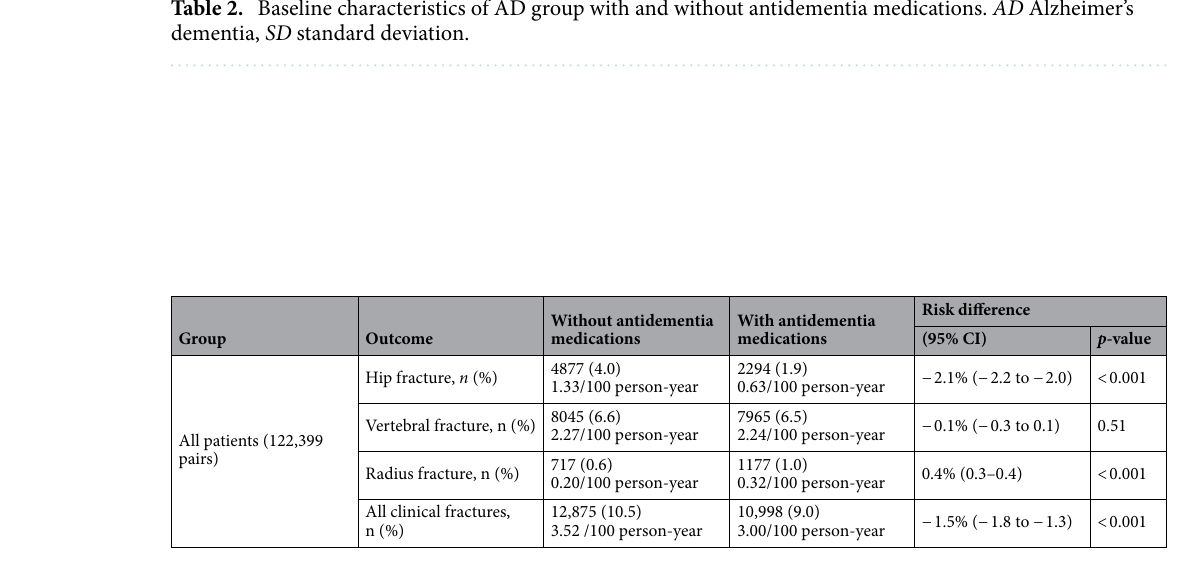
Table 3. Outcomes in the AD group with and without antidementia medications after propensity score matching. AD Alzheimer’s dementia, CI confidence interval.